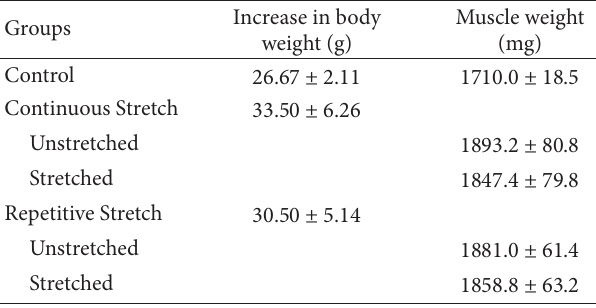
Table 1: Body weight and muscle weight.